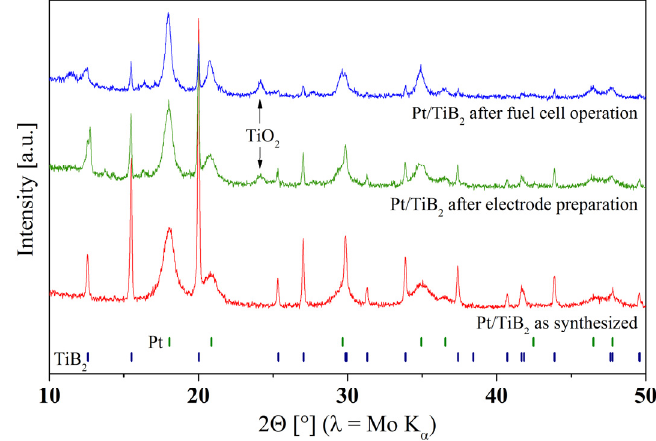
Figure 4. Diffraction patterns of Pt/TiB preparation into a porous electrode with no fuel cell operation ( middle ), after fuel cell operation ( top ). While the as-synthesized support can be described by pure TiB diffraction patterns display an additional peak of the TiO to oxidize during the electrode fabrication step.